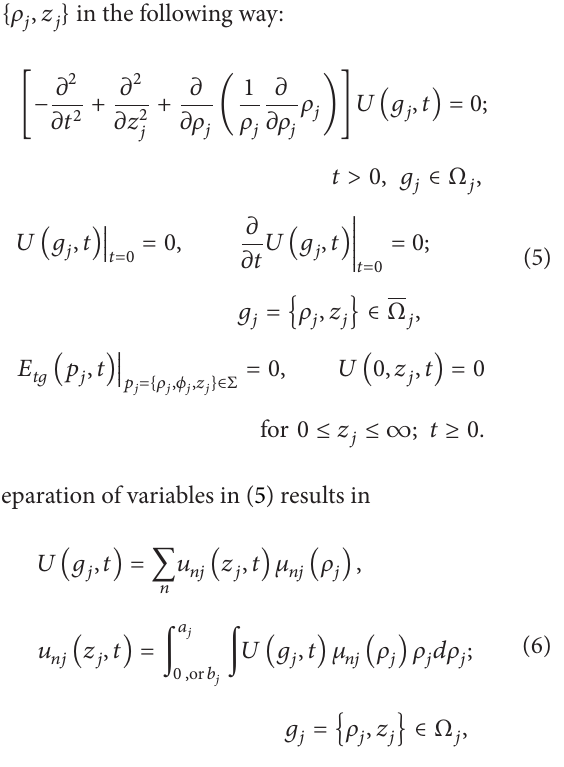
𝑈(𝑔, 𝑡) = 𝐻 (𝑔, 𝑡) for TM 𝑈(𝑔, 𝑡) deter- 𝜙 0 -waves. The function mines other nonzero field components as well: 𝐻 𝜌 , 𝐻 𝑧 in the case of TE 0 -waves and 𝐸 𝜌 , 𝐸 𝑧 in the case of TM 0 -waves (see, e.g., formulas (1.13) and (1.15) in [3]). By Σ = Σ 𝜙 × [0, 2𝜋]